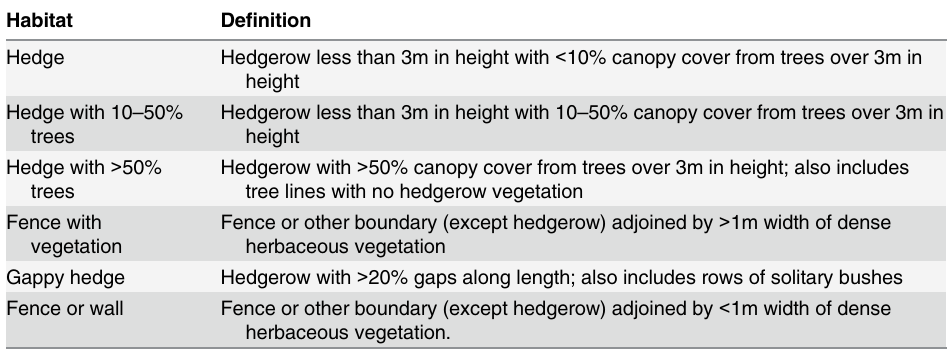
Table 1. Classification of boundary habitat vegetation.